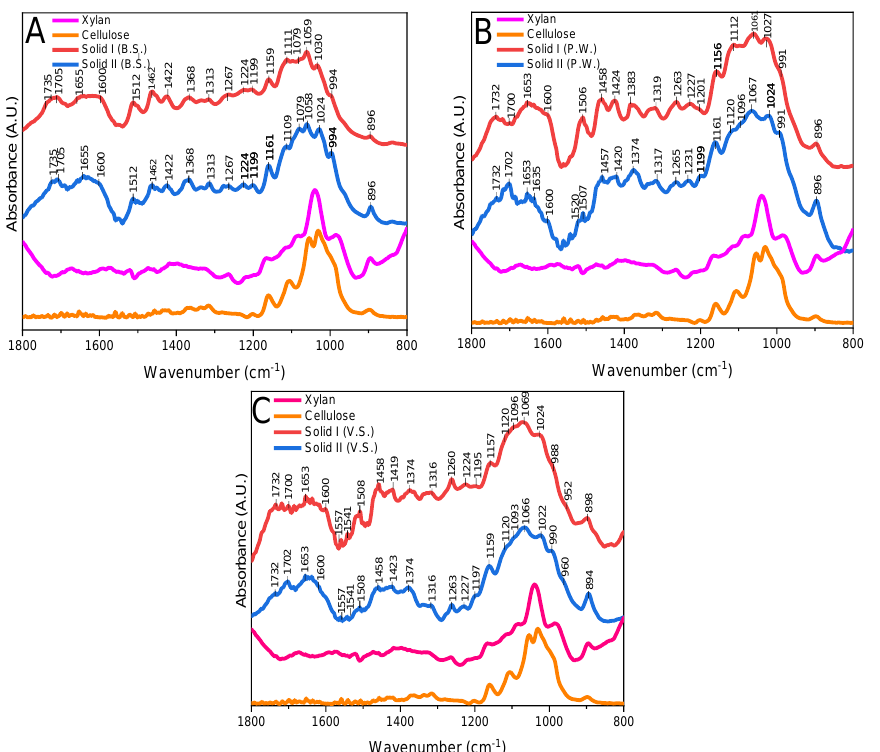
Figure 4. FTIR spectra of Solid I, Solid II, Solid III, and lignin (( A ) B.S.: barley straw; ( B ) P.W.: pruning waste; ( C ) V.S.: vine shoot).